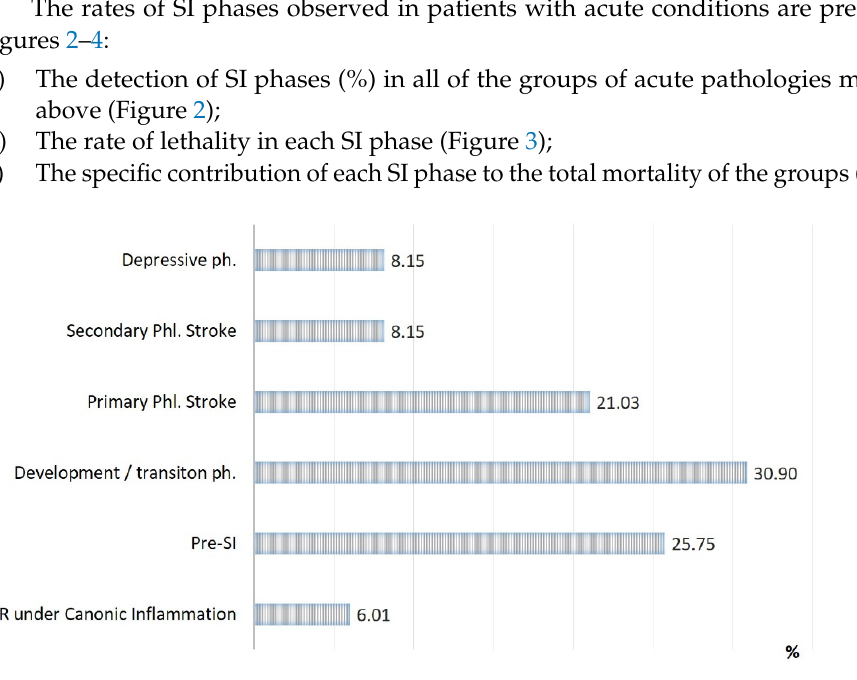
Figure 3. Lethality in each phase of SI (n = 71).